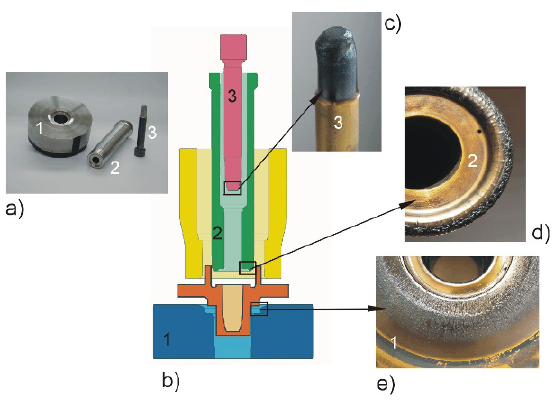
Figure 1. Wear of different elements of the forging dies set: a) el- ements of the forging dies set, b) configuration of mating elements, c,d,e) wear of different elements of the dies set.